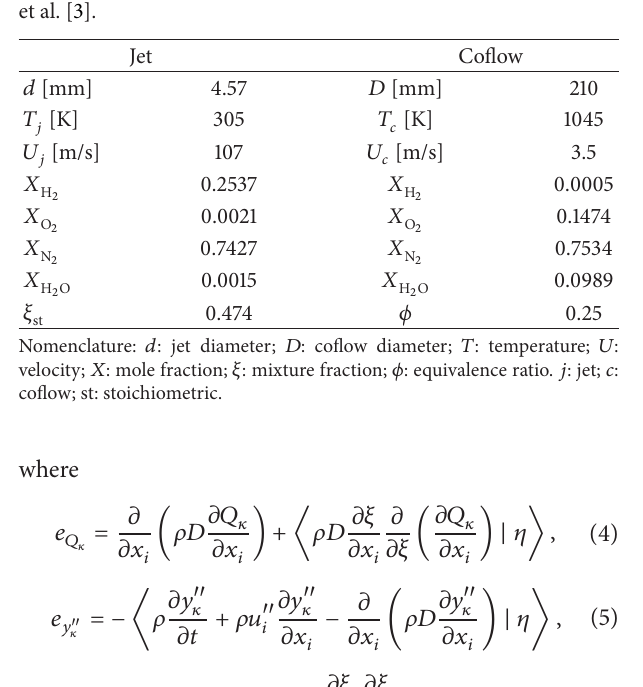
Figure 1: The lifted H 2 / N 2 flame. Reproduced from [3].